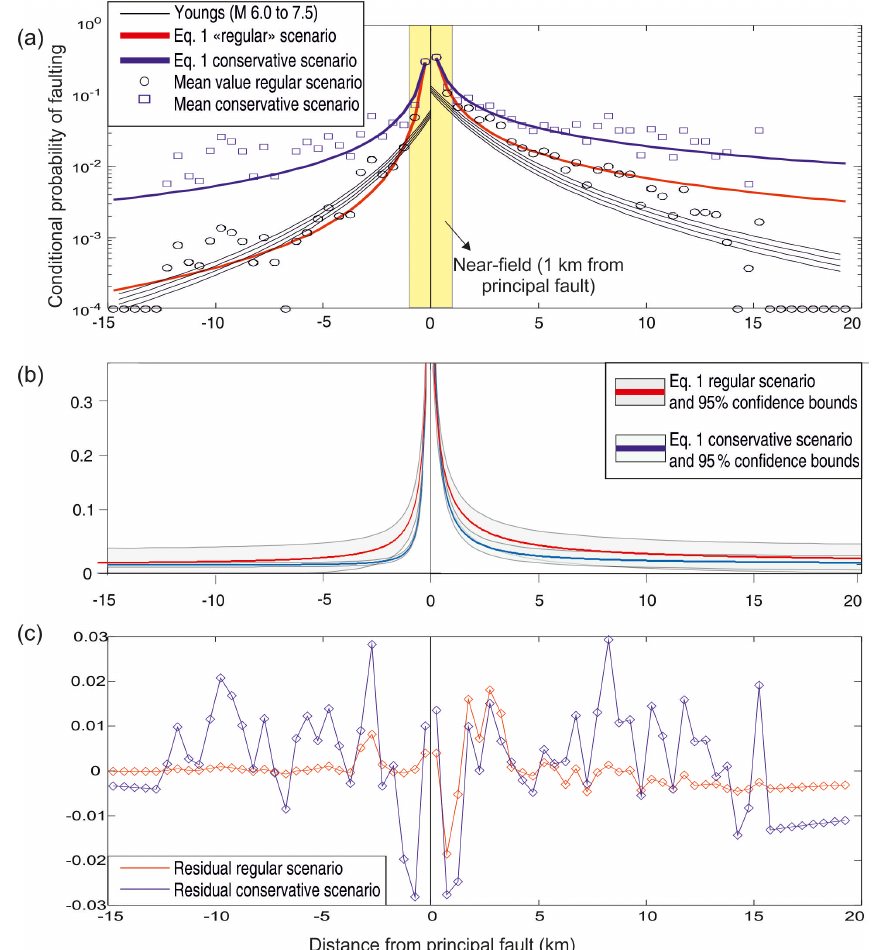
Figure 6. (a) Conditional probability of faulting as a function of distance from the principal fault. Black lines are the scaling relations by Youngs et al. (2003; their Eq. 7). Colored lines are the equations proposed in the present research (“regular” and “conservative” scenarios). Panel (b) shows the proposed equations and 95% confidence bounds ( y axis: linear scale). Panel (c) shows the residual plot (observed – predicted).